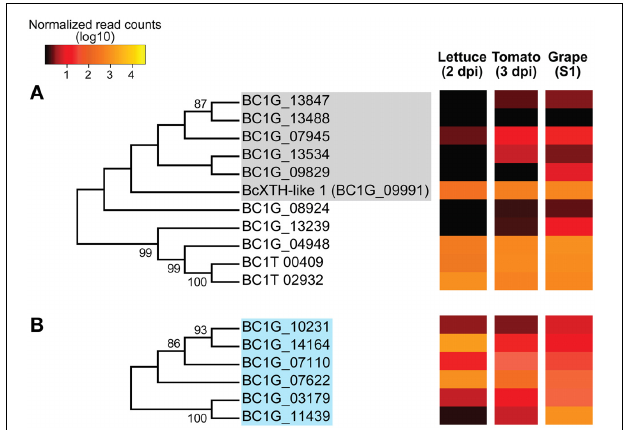
FIGURE 6 | Phylogenetic tree and expression levels of predicted xyloglucan (XyG) backbone-degrading enzymes. Bootstrap consensus trees inferred from 1000 replicates using the Neighbor-Joining method for the Botrytis CAZymes with predicted signal peptides in the GH16 (A) and GH3 (B) subfamilies. The percentages ( > 50%) of replicate trees in which the associated taxa clustered together in the bootstrap test are shown next to the branches. Colored-boxes in the phylogenetic trees indicate protein tribes ( > 2 members) determined by BLASTp alignments ( e -value < 1e − 6) and Tribe-MCL (Enright et al., 2002). Gray box in (A) correspond to tribe 5, while the light blue box in (B) refers to tribe 4 (Supplemental Table S2). The colors in the heat maps represent the number of DESeq-normalized transcript counts (log10) of the Botrytis genes in infected lettuce leaves, ripe tomato fruit and grape berries.